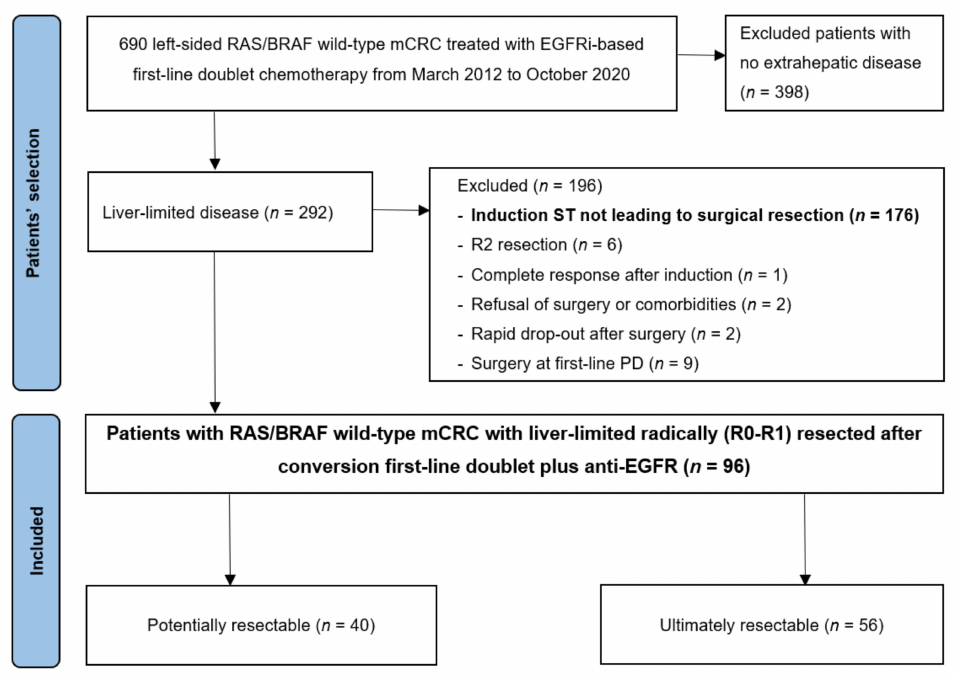
Figure 1. Flow diagram with patients’ selection and disposition. Three out of six R2 patients were resected with a palliative intent. ST: systemic treatment.